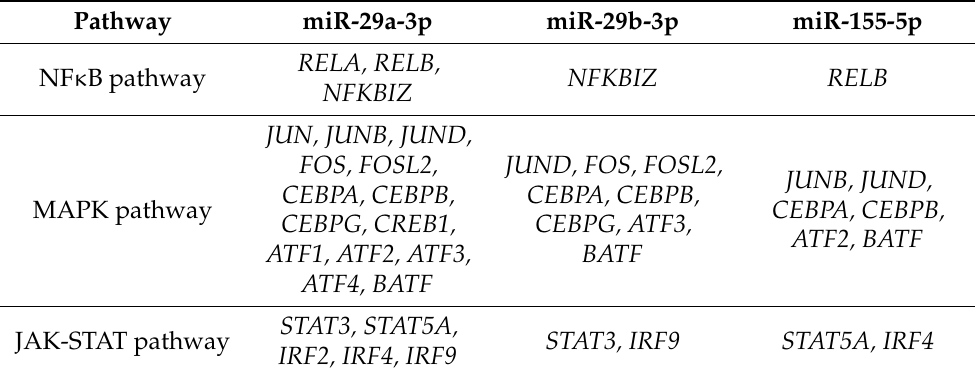
Table 1. Transcriptions factors affecting expression of miR-29a-3p, miR-29b-3p, and miR-155-5p were identified using the database GeneCards v5.3.